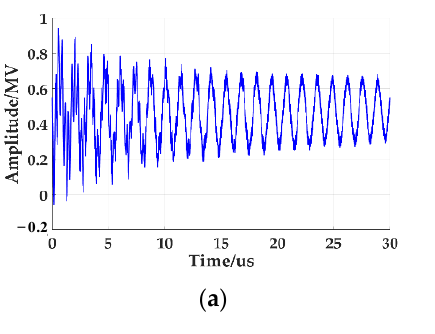
Figure 11. VFTO waveform injected into the front end of the transformer. ( a ) Time domain waveform. ( b ) Spectrogram.